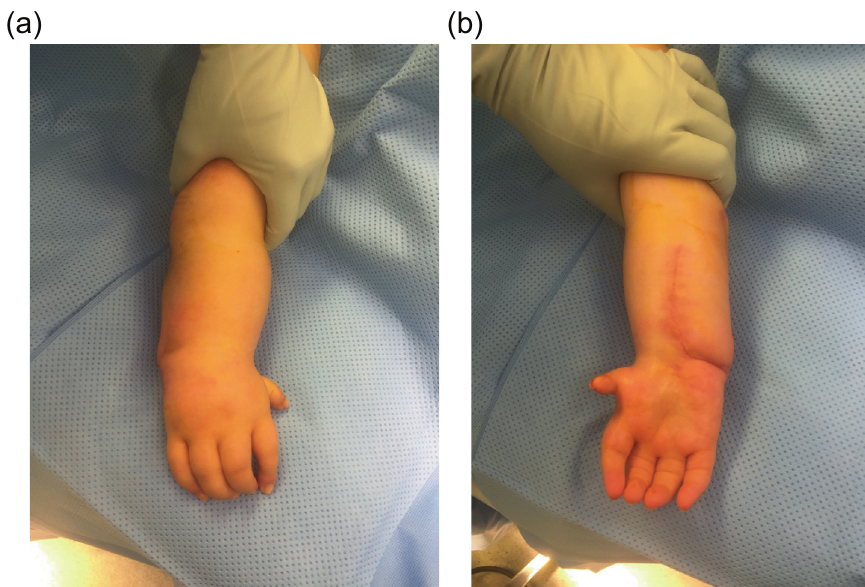
Figure 29. Final photographs, dorsal view (a), volar view (b), showing the hand after ulnarization with